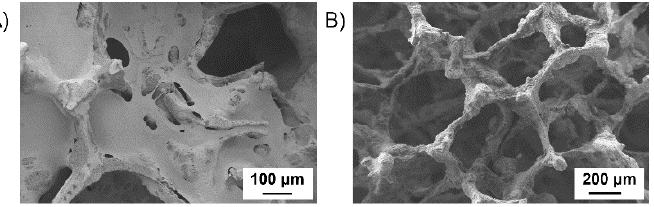
16 of 29 Figure 5. SEM images of a BG scaffold coated in a KHC2000E2000 solution in chloroform with 0.5% w / v ( A , B ) or 1% w / v ( C , D ) concentration through a 1-min ( A , C ) or a 1-day ( B , D ) dip-coating proce- dure. Considering that the 1-min dip-coating procedure in a polymer solution at 1% w / v concentration resulted to be the best condition to coat BG scaffolds with KHC2000E2000, the same procedure was adopted to produce KHC2000/BG scaffolds. However, KHC2000- coated BG scaffolds according to this protocol reported many clogged pores, probably